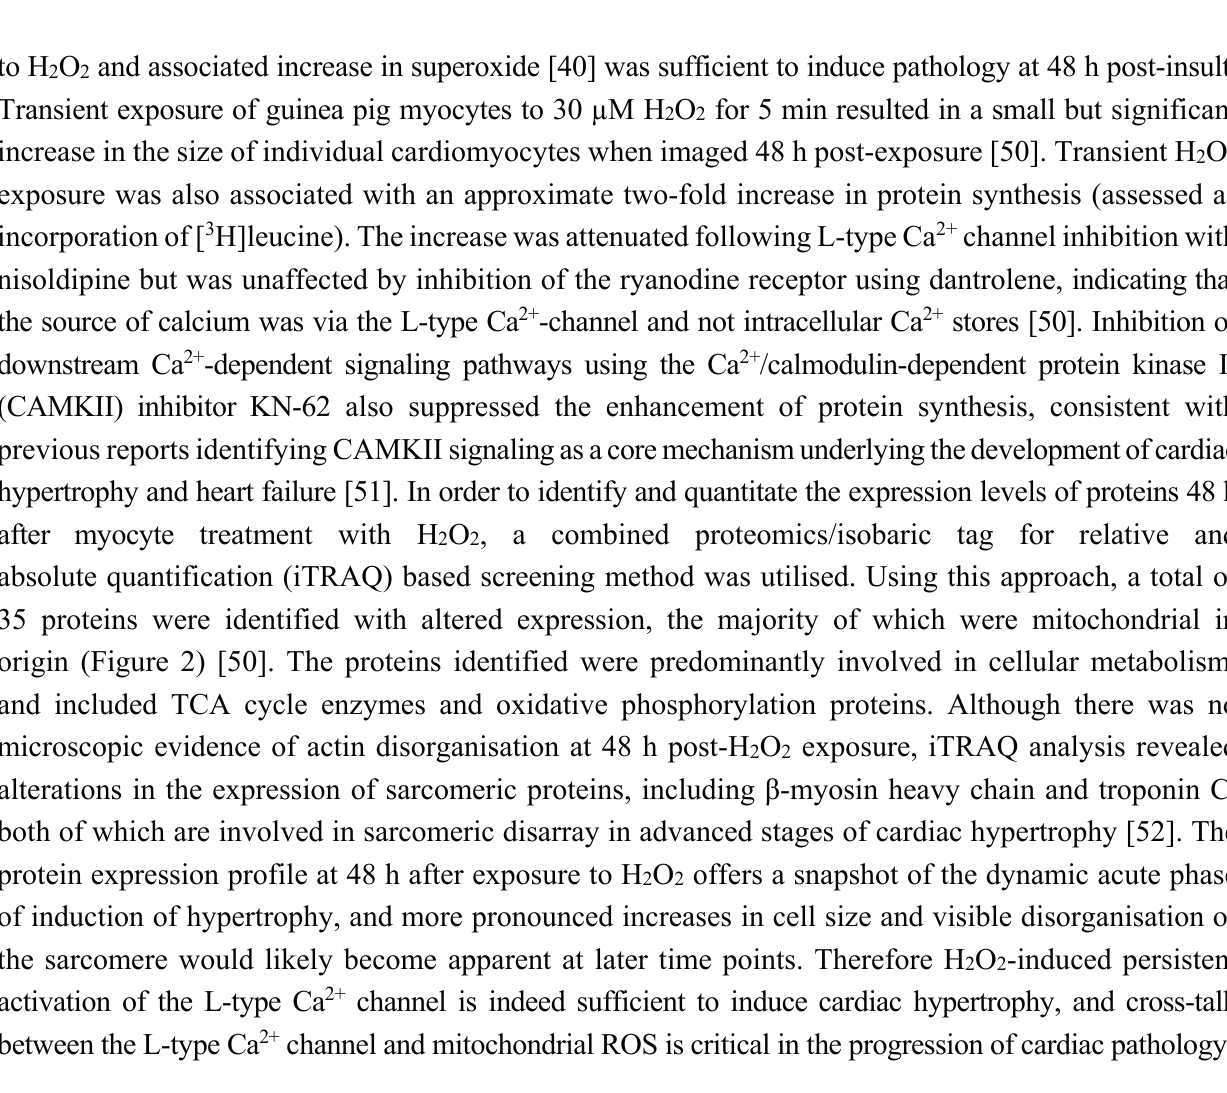
Figure 2. Transient exposure of myocytes to H 2 O 2 alters mitochondrial protein